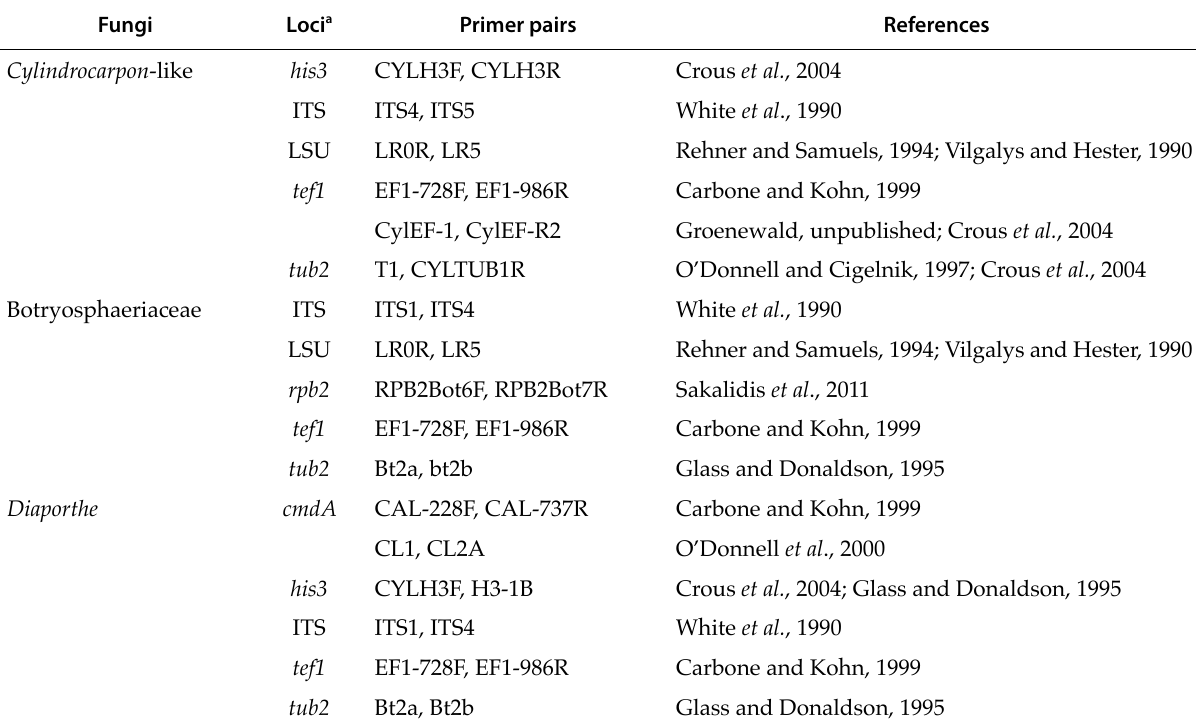
Table 1. Loci and primer pairs used to amplify selected gene regions for the main groups of grapevine trunk disease fungi obtained in this